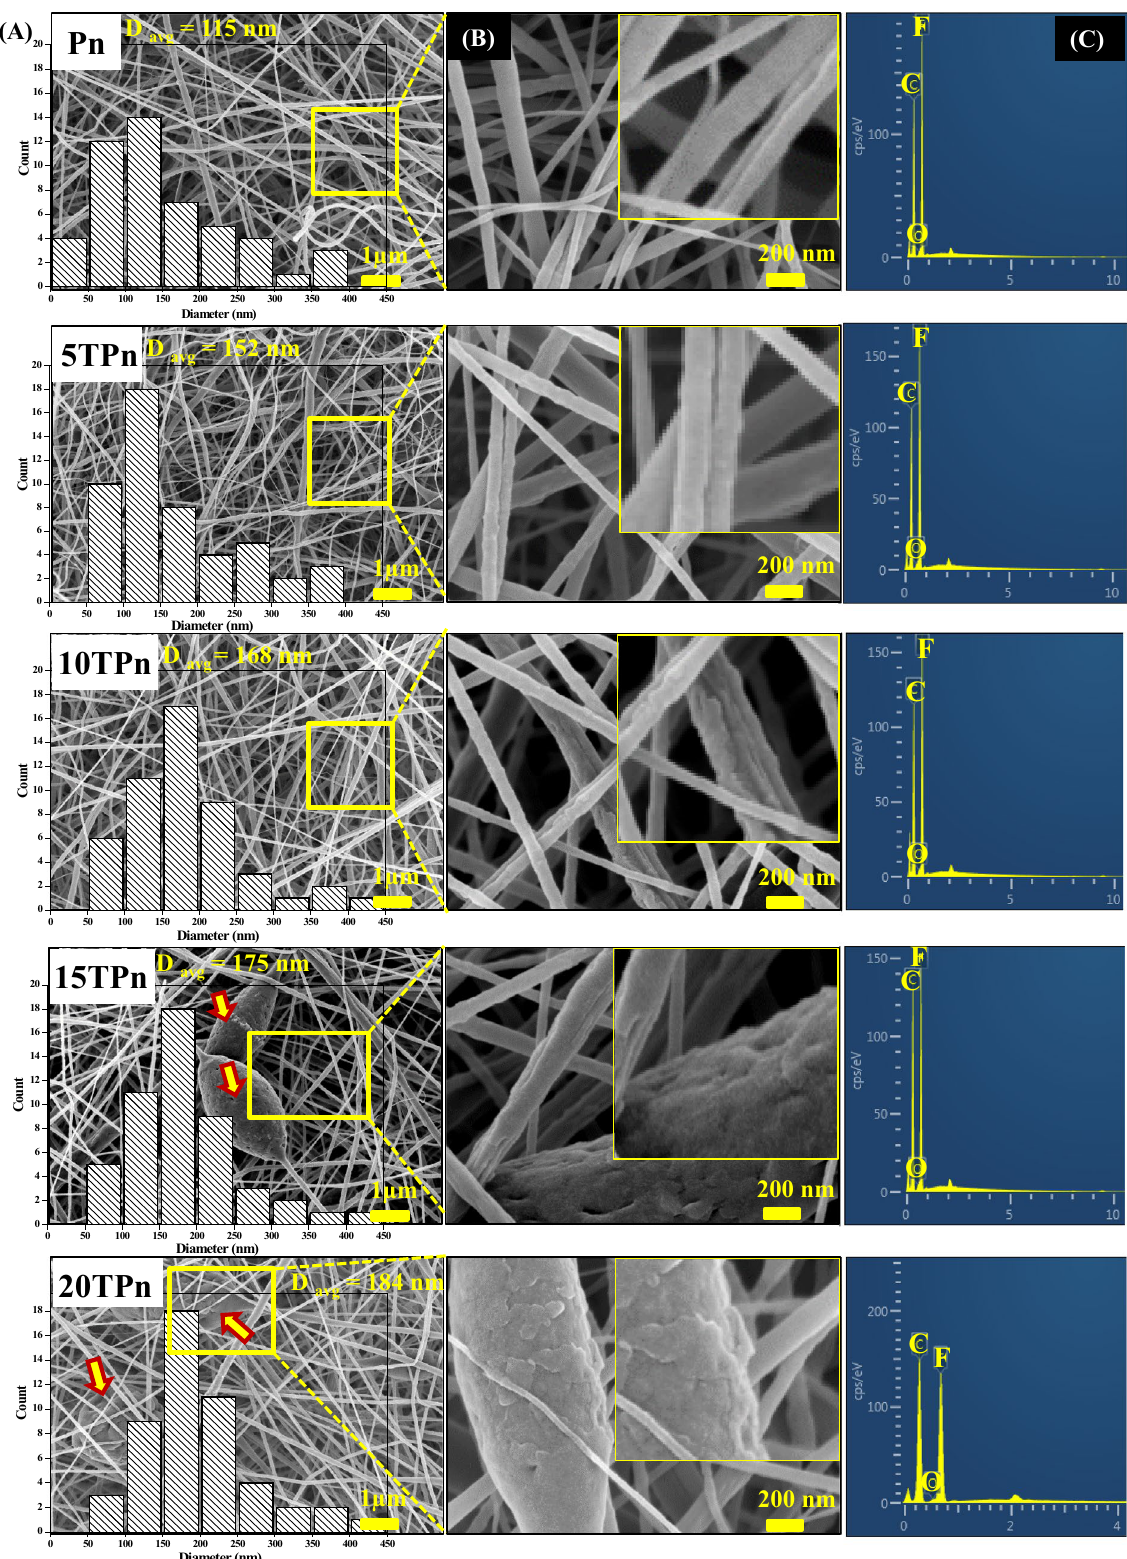
Figure 2. TPS/PVDF nanofibers: ( A ) Diameter distribution histogram and FESEM images at less magnification, ( B ) high magnification FESEM images and ( C ) EDX